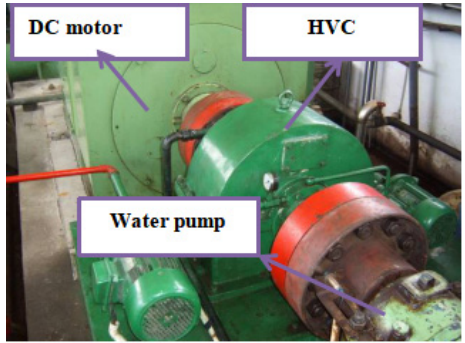
Figure 10. Test field of HVC.